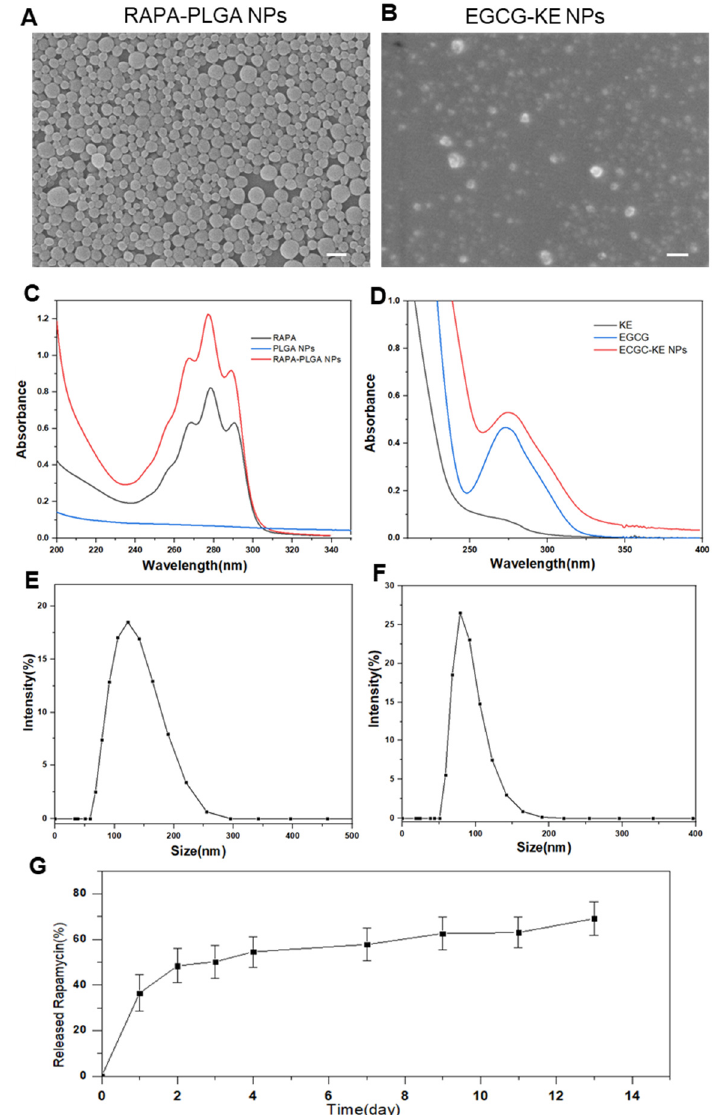
Figure 3. Characterization of NPs. SEM image of PLGA-RAPA NPs ( A ) and EGCG-KE NPs ( B ). Scale bar: 200 nm. UV–vis of PLGA-RAPA NPs ( C ) and EGCG-KE NPs ( D ). Particle size distribution with a photograph of PLGA-RAPA NPs ( E ) and EGCG-KE NPs ( F ) in water. ( G ) In vitro release test of RAPA-PLGA NPs ( n = 3, mean ± SD).